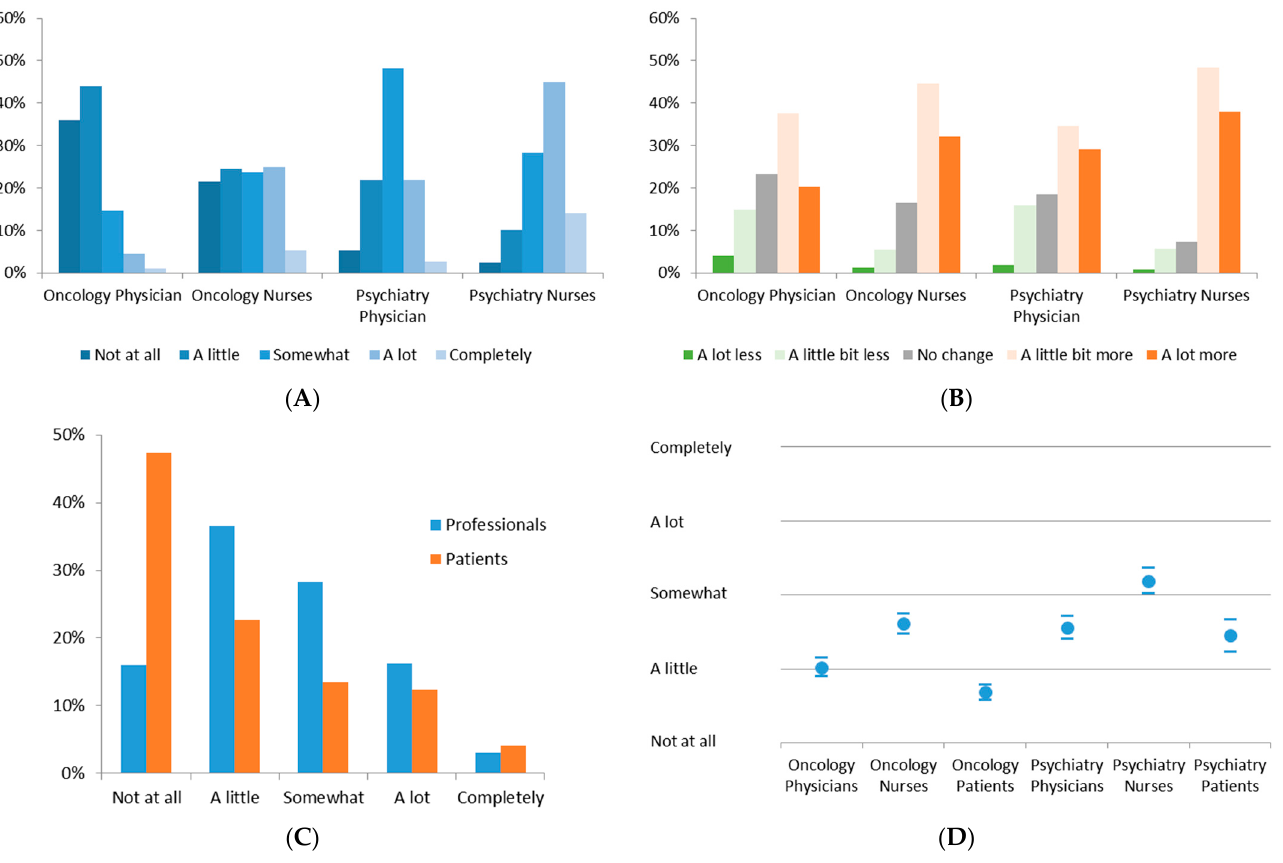
Figure 1. ( A ) Required modifications in clinical management due to pandemic; ( B ) changes in work- load due to pandemic situation; ( C ) histogram of uncertainty perception throughout all participating groups; ( D ) decisional uncertainty within the stakeholder groups (mean and 95% CI).